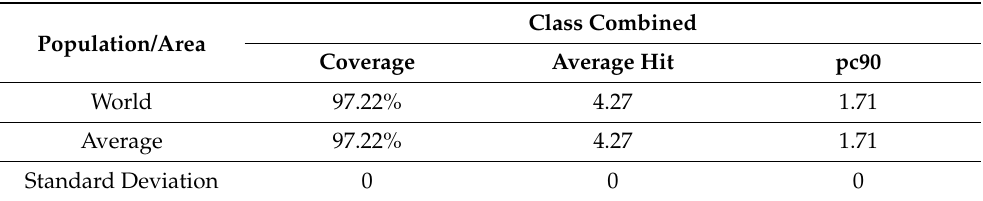
Table 1. Population coverage analysis of the selected MHC-I and MHC-II epitopes of the vaccine construct, as predicted by the IEDB server.